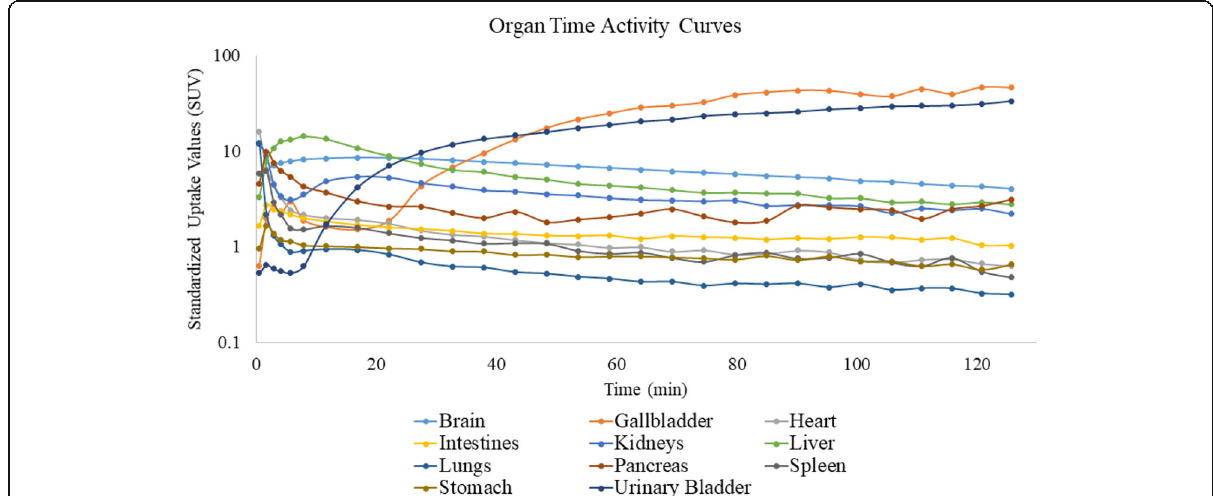
Fig. 2 Representative decay-corrected time-activity curves of 11 C-UCB-J for organs used in dosimetry calculations, in standardized uptake value (log scale)